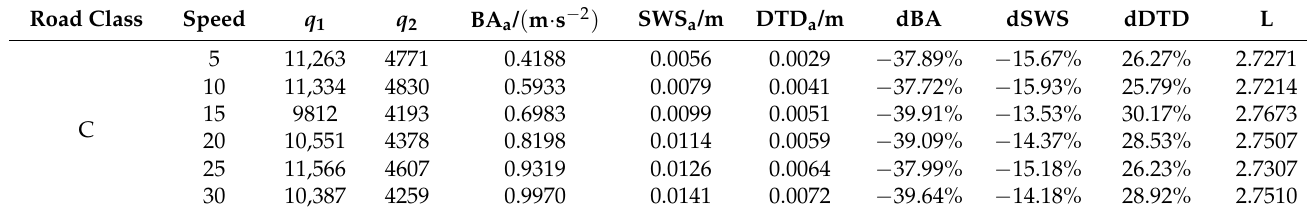
Table 9. Optimal solution and simulation results of comfort mode under C-class road.